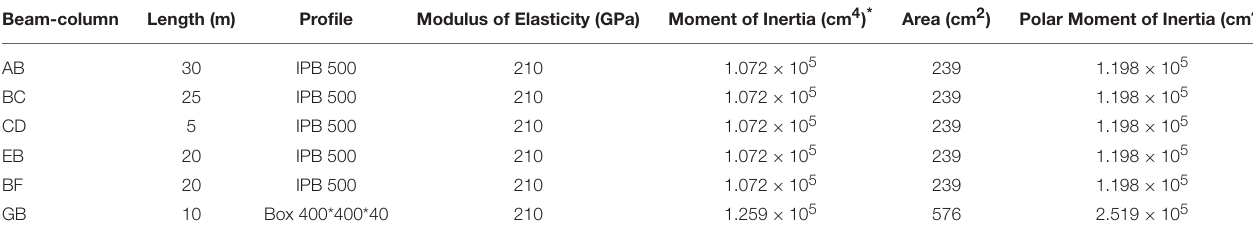
TABLE 3 | Properties of the structural members in Figure 10A . Beam-column